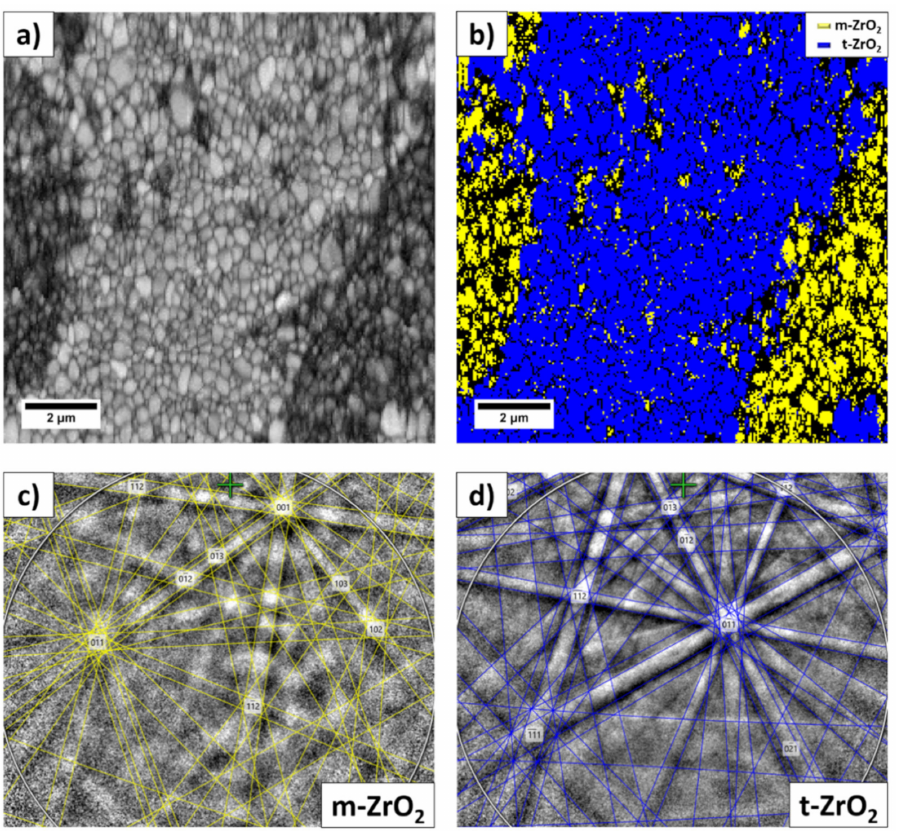
Figure 8. EBSD data of the 3.5 mol% Y 2 O 3 -ZrO 2 sintered at 1400 ◦ C for 2 h: ( a ) band contrast (pattern quality) map showing basic grain structure, ( b ) phase map, ( c ) indexed Kikuchi patterns of the m-ZrO 2 , and ( d ) indexed Kikuchi patterns of the t-ZrO 2 . Table 2. Vickers hardness (HV), critical stress intensity factor (K Ic ), strength ( σ ), and density (d).